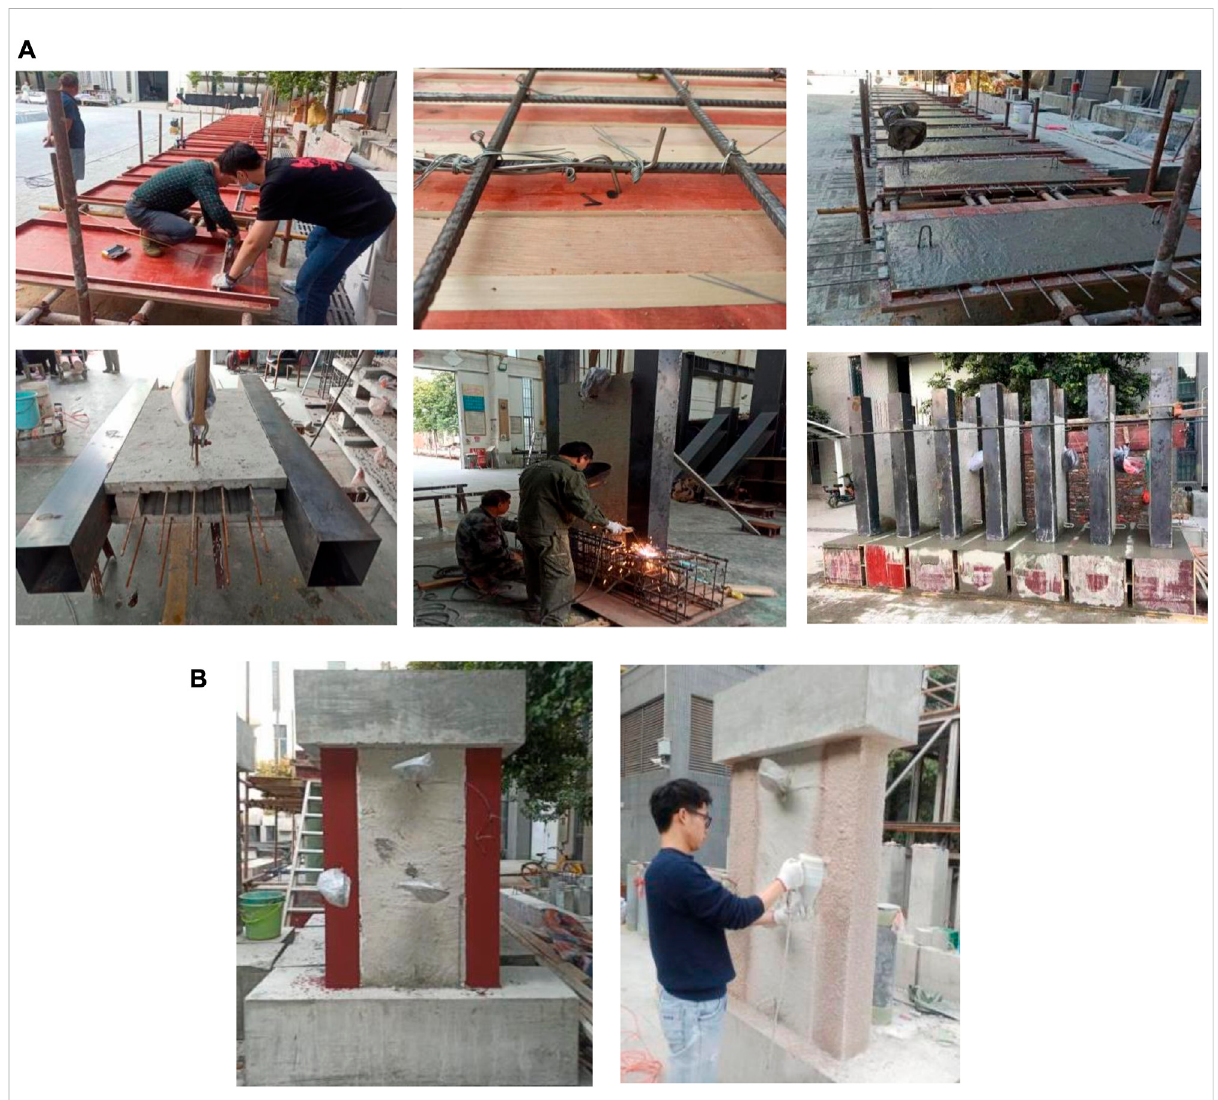
FIGURE 3 Production process of specimens: (A) Concrete pouring of specimens; (B) Construction procedure of fi re-retardant coating.